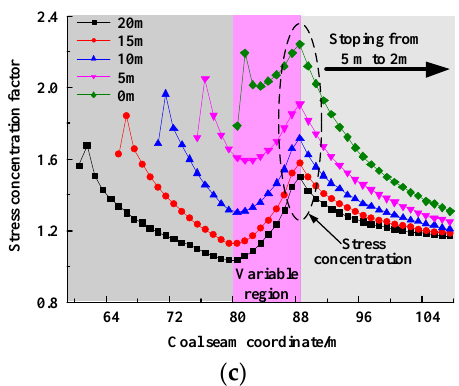
Figure 9. Numerical model of the variation of coal seam thickness, in-situ stress distribution, and abutment pressure distribution [23], ( a ) numerical model of the variation of coal seam thickness, ( b ) distribution of the in-situ stress, ( c ) distribution of abutment pressure when stoping with coal seam thickness of 5 to 2 m.